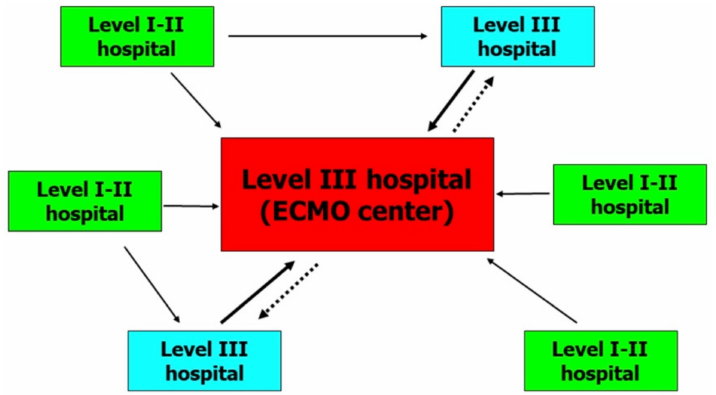
Figure 1. Organizational model for a regional extracorporeal membrane oxygenation (ECMO) net- work. Continuous lines indicate urgent transports and dashed lines indicate back